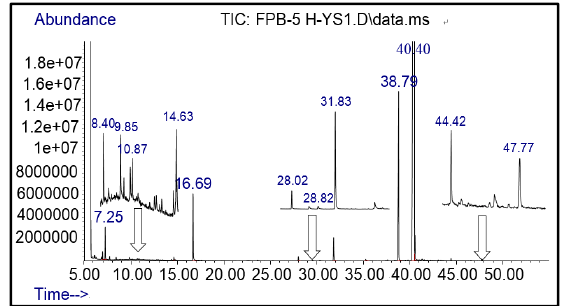
Figure 4. The Total Ion Chromatography (TIC) of derivatized photolytic products of FPB. Compared with the MS of FPB (compound 10, m / z 383), there was a fragment with m / z of Table 1. Speculative photolytic products of FPB by nano-TiO 2 mediated.